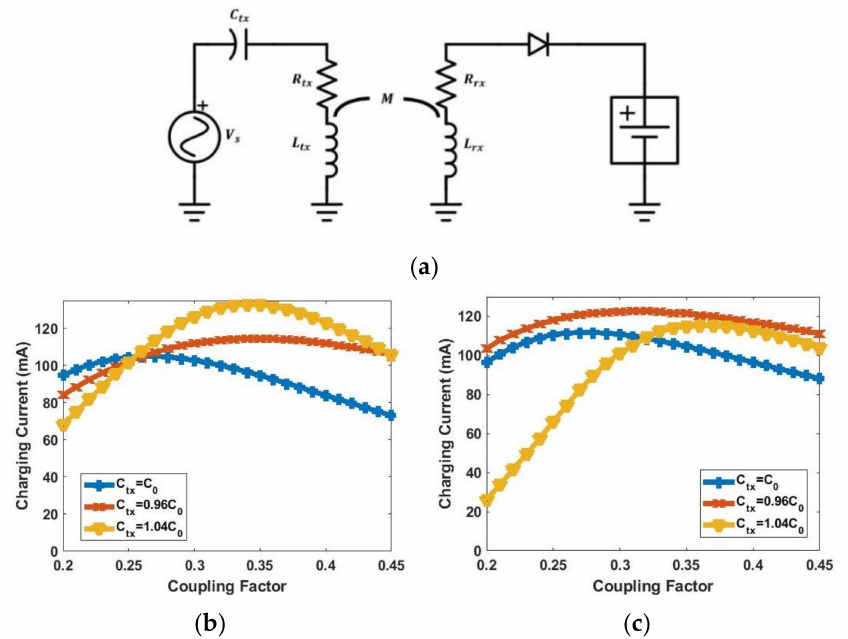
Figure 17. ( a ) Wireless-charging hanger system schematic without using Class-E rectifier circuit model; ( b ) simulated charging current using Figure 16a; ( c ) simulated charging current using Figure